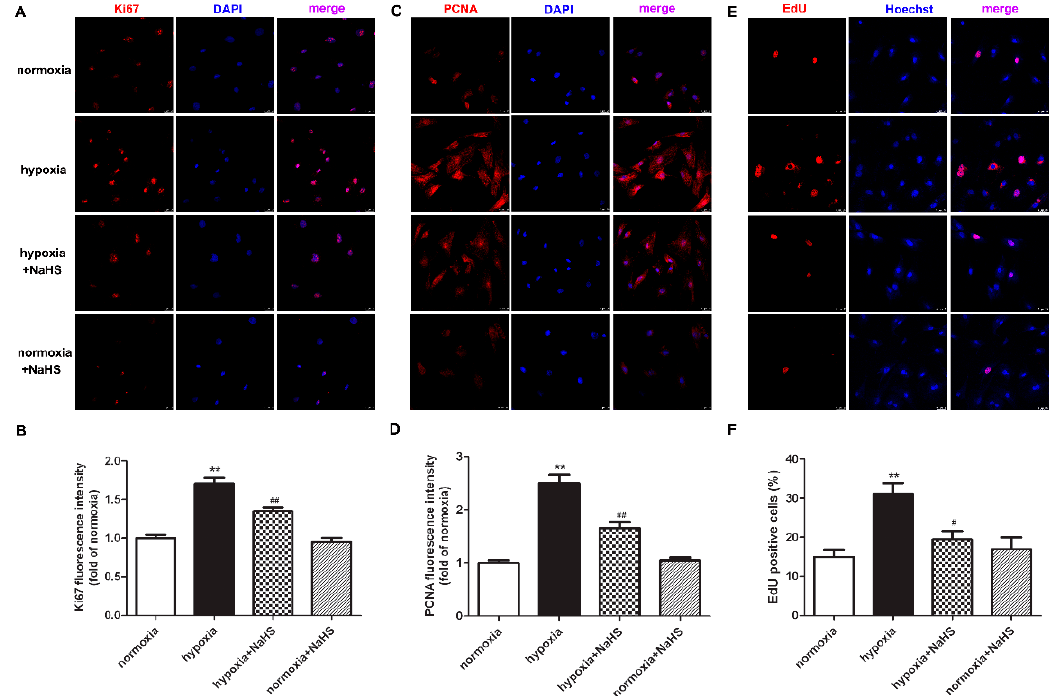
Figure 2. NaHS inhibited the Ki67 and PCNA expression, and reduced the EdU positive cells in the cardiac fibroblasts with hypoxia. After pre-administration with NaHS (50 µ M) for 4 h, neonatal rat cardiac fibroblasts were subjected to normoxia (containing 5% CO 2 and 95% O 2 ) or hypoxia (containing 5% CO 2 and 1% O 2 ) for 4 h. ( A – D ) Ki67 and PCNA was immunofluorescence stained respectively with Cy3 (red)-conjugated IgG. The nuclei were stained with DAPI (blue). Bar = 25 µ m. The fluorescence intensity was quantified using ImageJ software. ( E ) Cell proliferation was assessed by EdU (red) staining. The nuclei were stained with Hoechst (blue). Bar = 25 µ m. ( F ) The rate of EdU positive cells was quantified. ** p < 0.01 vs. normoxia; # p < 0.05, ## p < 0.01 vs. hypoxia, n = 6.